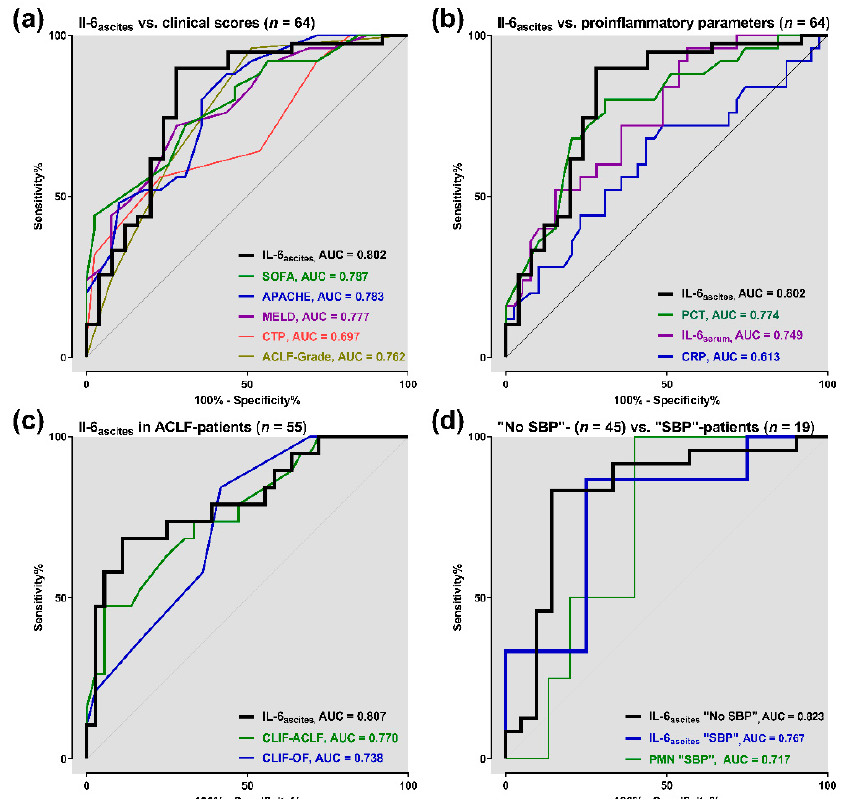
Figure 1. Prognostic accuracy of baseline ascitic interleukin 6 (IL-6 ascites ) to predict 3-month mortality: ( a ) IL-6 ascites versus clinical scores ( n = 64); ( b ) IL-6 ascites versus proinflammatory parameters ( n = 64); ( c ) IL-6 ascites in acute-on-chronic liver failure (ACLF) patients ( n = 55); ( d ) IL-6 ascites in “ non-spontaneous bacterial peritonitis (No SBP) ” patients ( n = 45) versus IL-6 ascites and polymorphonuclear neutrophils (PMN) in “ spontaneous bacterial peritonitis (SBP) ” patients ( n = 19). APACHE: acute physiology and chronic health evaluation II; SOFA: sequential organ failure assessment; MELD: model of end-stage liver disease; CTP: Child–Turcotte–Pugh; CLIF-OF: chronic liver failure organ failure score; CLIF-ACLF: chronic liver failure acute-on-chronic liver failure score; CRP: C-reactive protein; PCT: procalcitonin; AUC: area under curve.